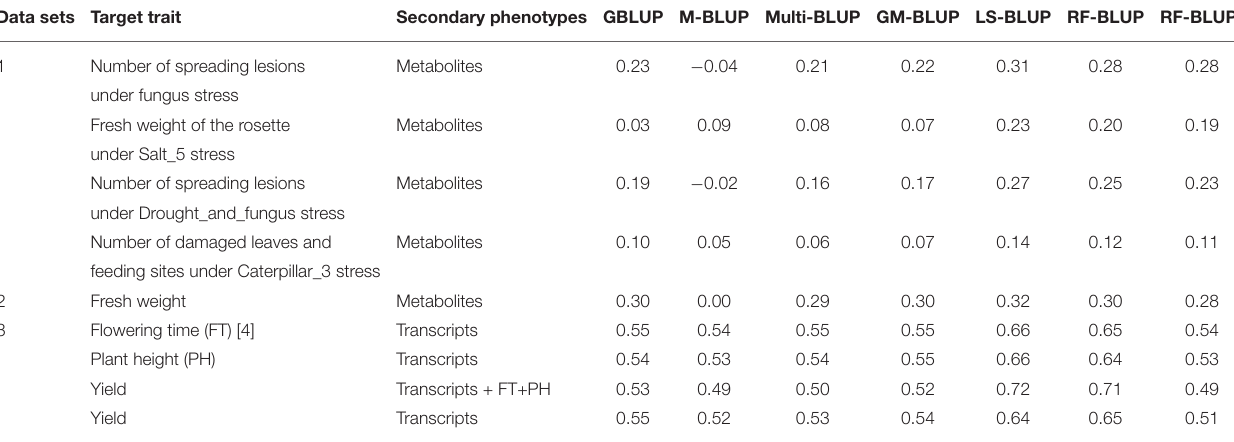
Data sets Target